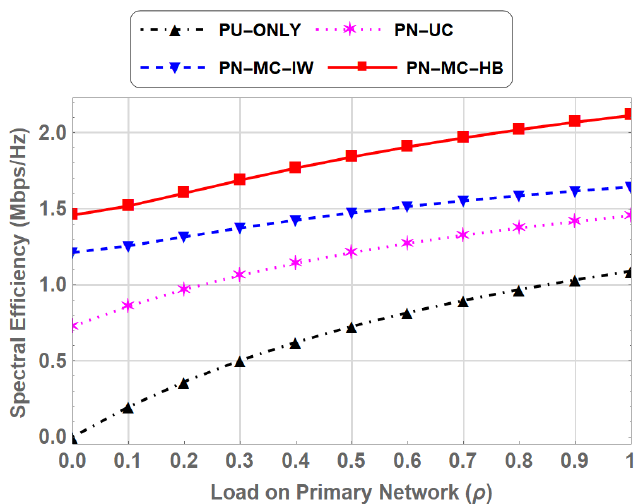
Figure 14. Comparison of Spectral Efficiency for PN-ONLY, PN-UC, PN-MC-IW and